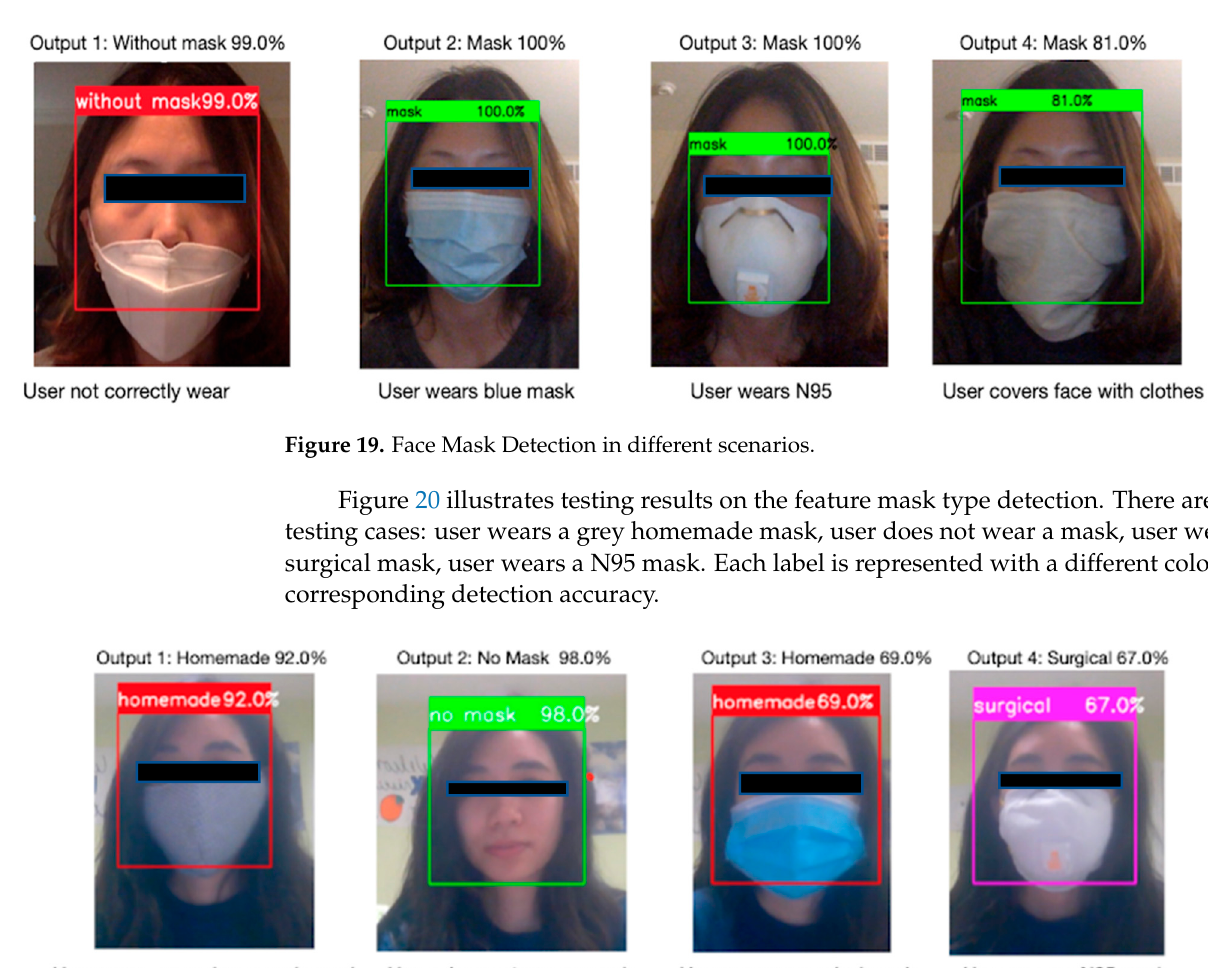
Figure 21. Mask Position Detection in different scenarios.